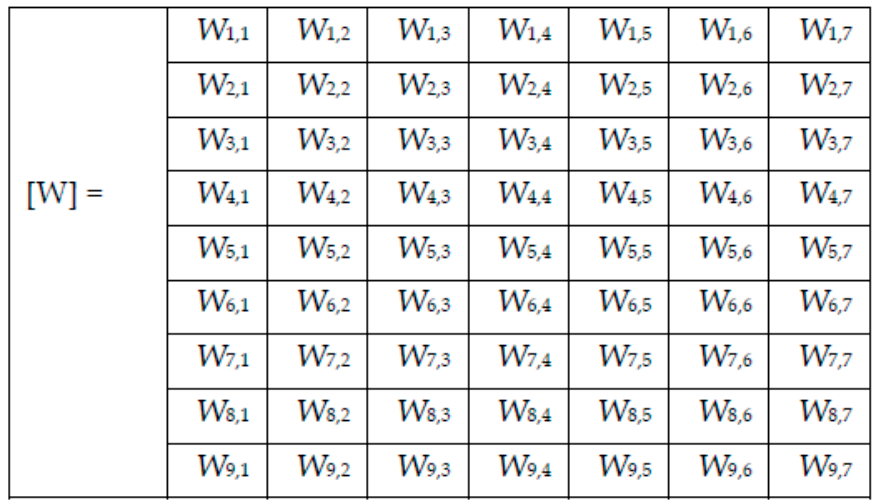
Figure 5. Weight matrix [ W ].